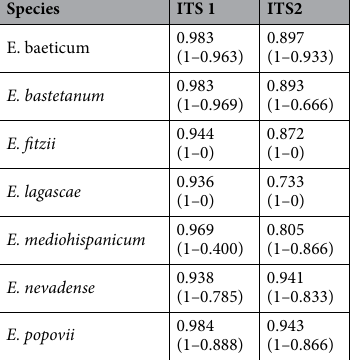
Table 2. Average haplotype diversity (Hp) per species, estimated for ITS1 and ITS2 samples. Maximum and minimum values (in parentheses) refer to individual samples.